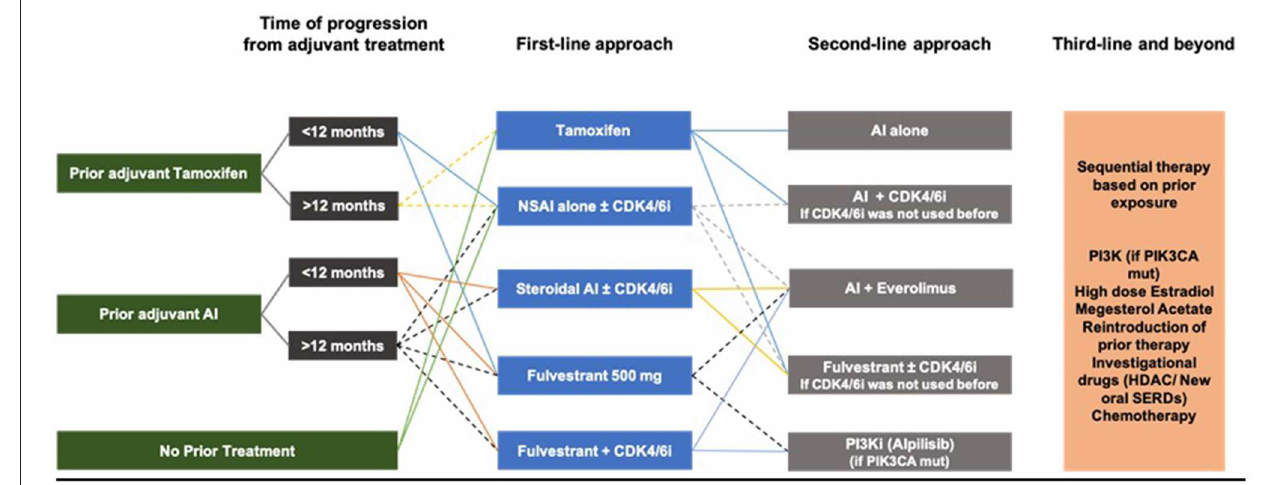
FIGURE 4 | Our suggested sequence of treatment in HR + /HER2–